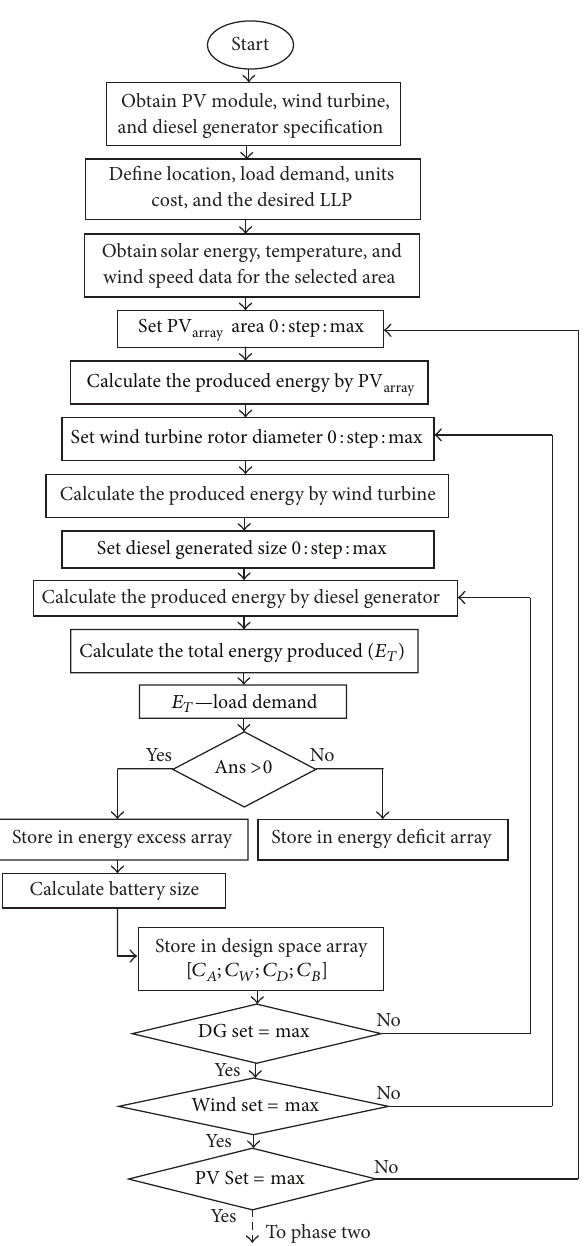
Figure 3: The first phase of the proposed optimization algorithm.